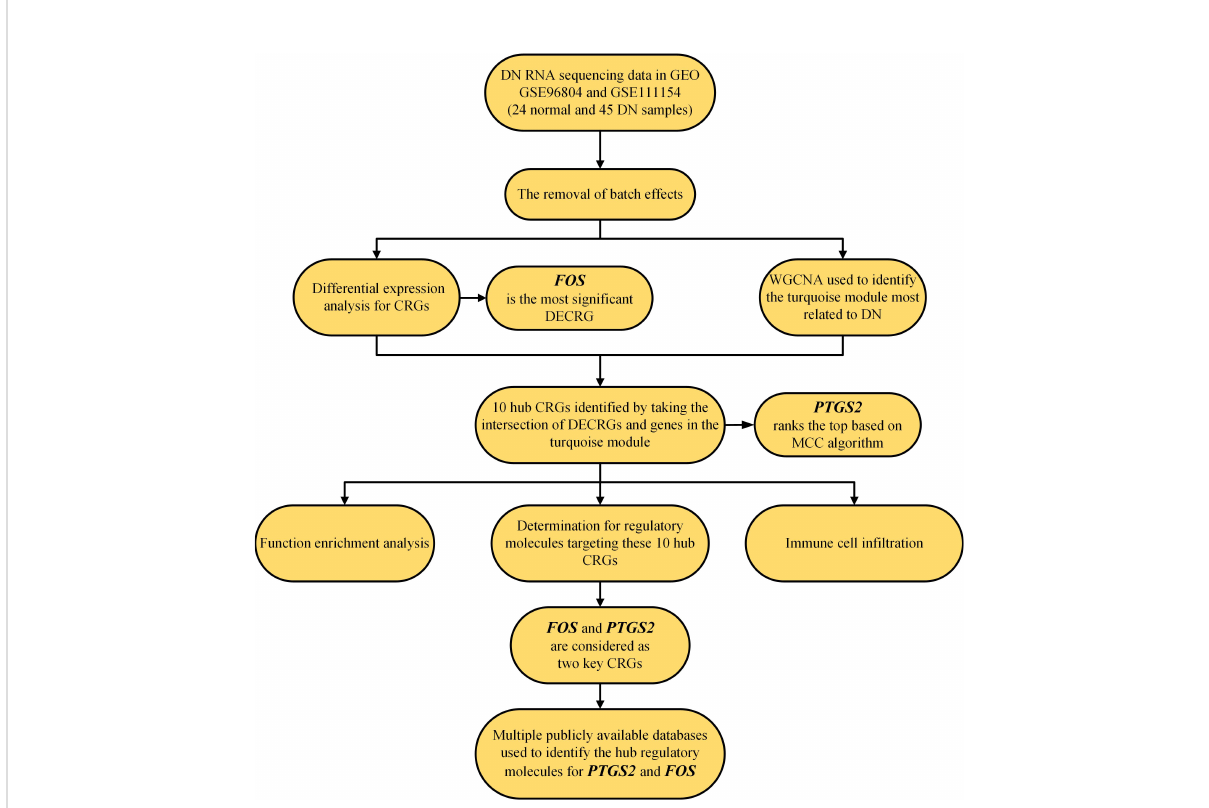
FIGURE 1 Flow chart of this study. CRG, copper-related gene; DECRGs, differentially expressed copper-related genes; and DN, diabetic